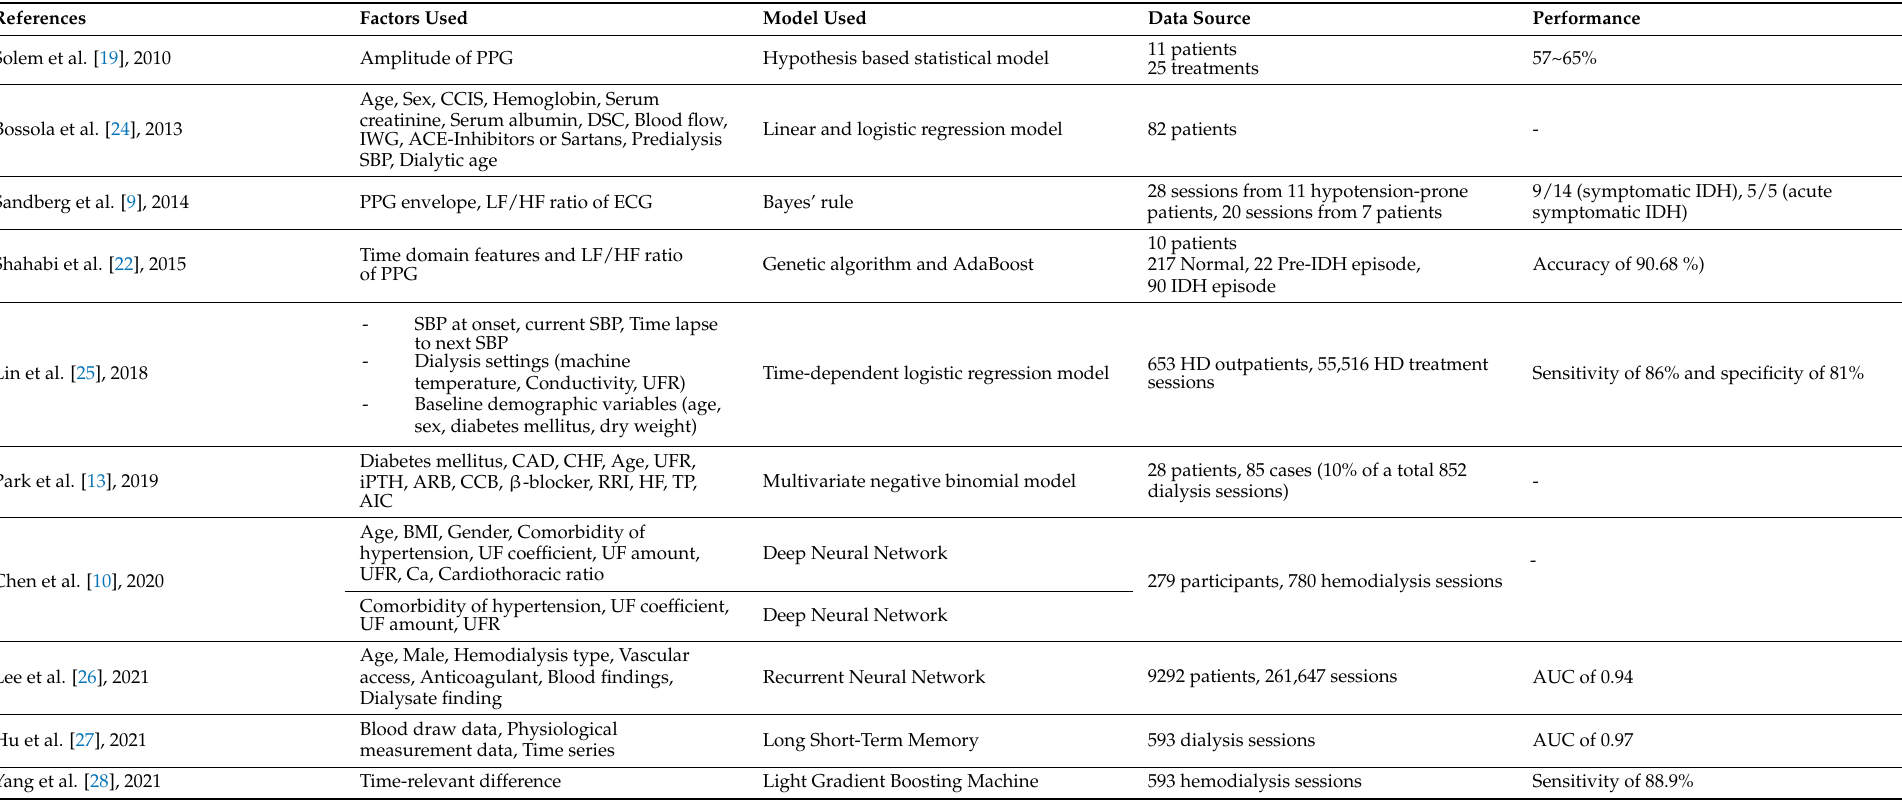
Table 1. Comparison of IDH prediction models developed to